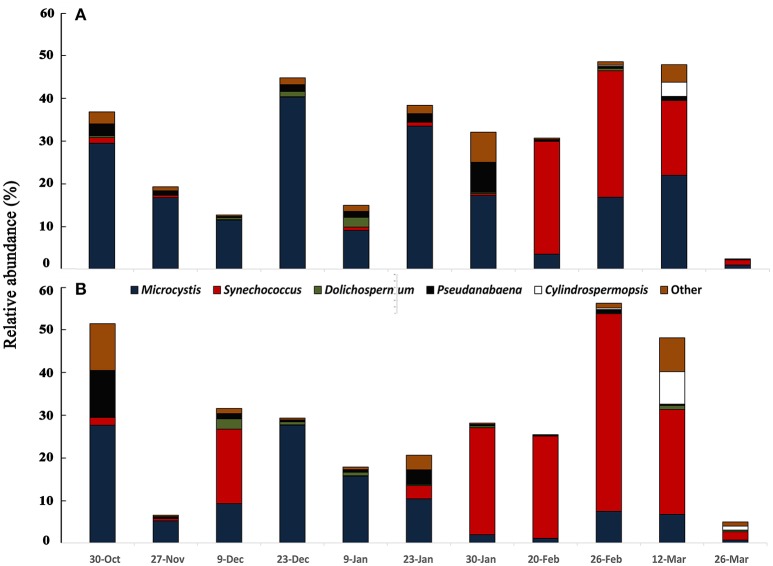
Variation of cyanobacterial community accessed by 16S rDNA sequencing from October 2013 to March 2014 in two sampling points of Funil reservoir (A) point 1, central part, (B) point 2, near the dam.